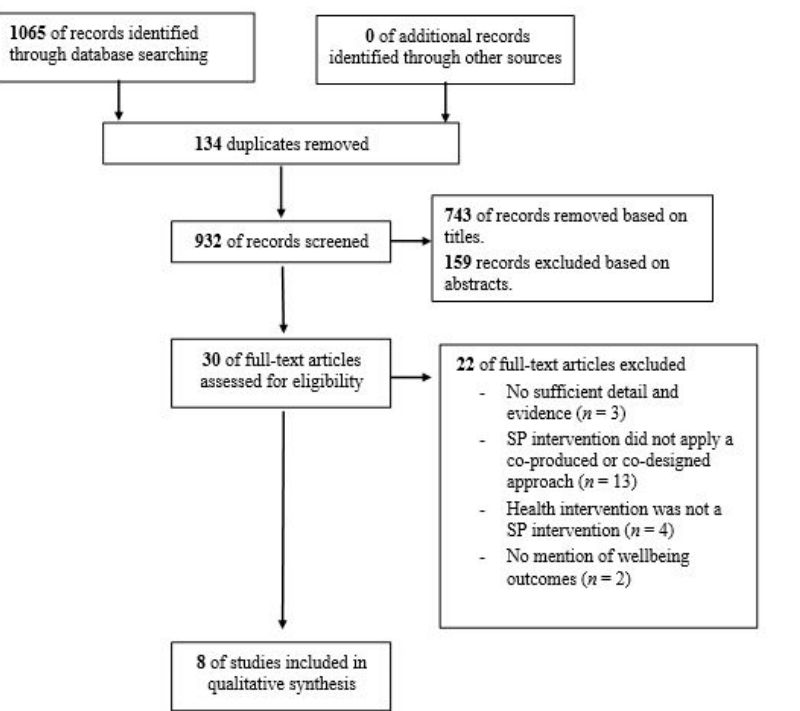
Figure 1. Preferred Reporting Items for Systemic Reviews and Meta-Analyses (PRISMA) [29] flow diagram for search outcomes and screening process.